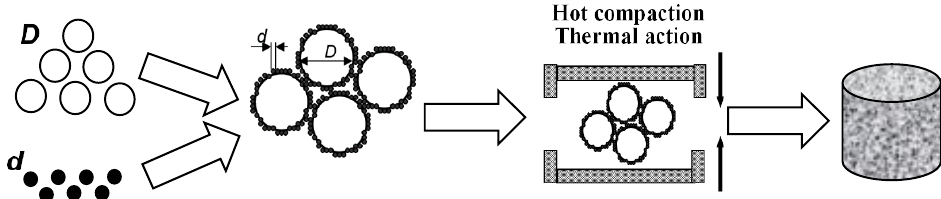
Figure 2. Scheme of the formation process of the segregated polymer composites by the method of hot compaction, where d — diameter of the CB particles, D — diameter of the PLA